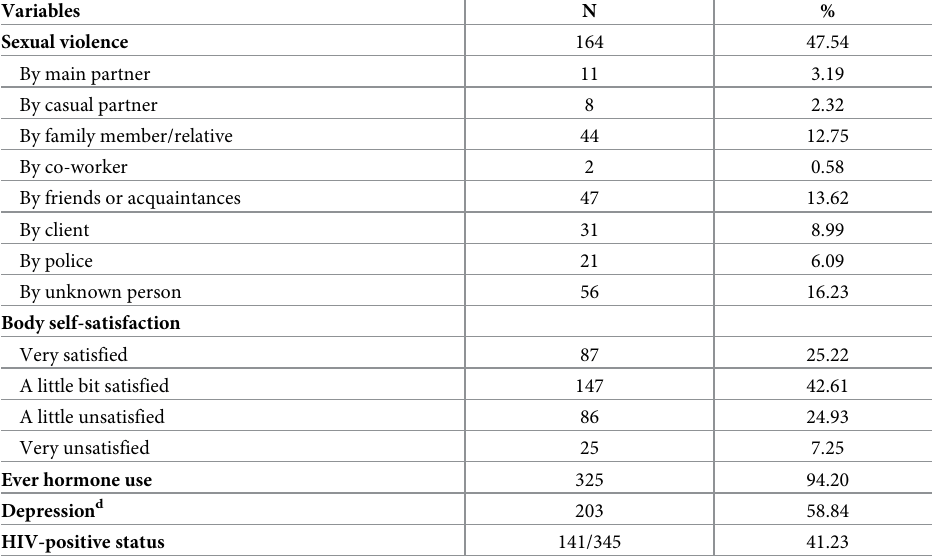
(Table 1). The sample characteristics show that 69.57% of the participants were aged 18 to 35 years, 75.07% self-reported as Black/Brown, 41.51% had up to 12 years of schooling, 94.49% were heterosexual, and 43.61% earned less than or equal to US$130 per month. 48.41% of par- ticipants were currently engaging in sex work. Only 25.22% of participants were very satisfied with their bodies. HIV prevalence was 41.23%. Rates of ever experiencing discrimination, psy- chological violence, physical and sexual violence were, respectively, 91.64%, 85.80%, 54.20%, and 47.54%. A positive depression screening occurred in 58.8% (Table 1). In the initial adjustment model, sexual orientation was positively associated with lifetime suicidal ideation, and current sex work was negatively associated with the outcome (Table 2). Living alone and sexual violence by family were factors positively associated with lifetime attempted suicide (Table 3). Positive depression screening was positively associated with both